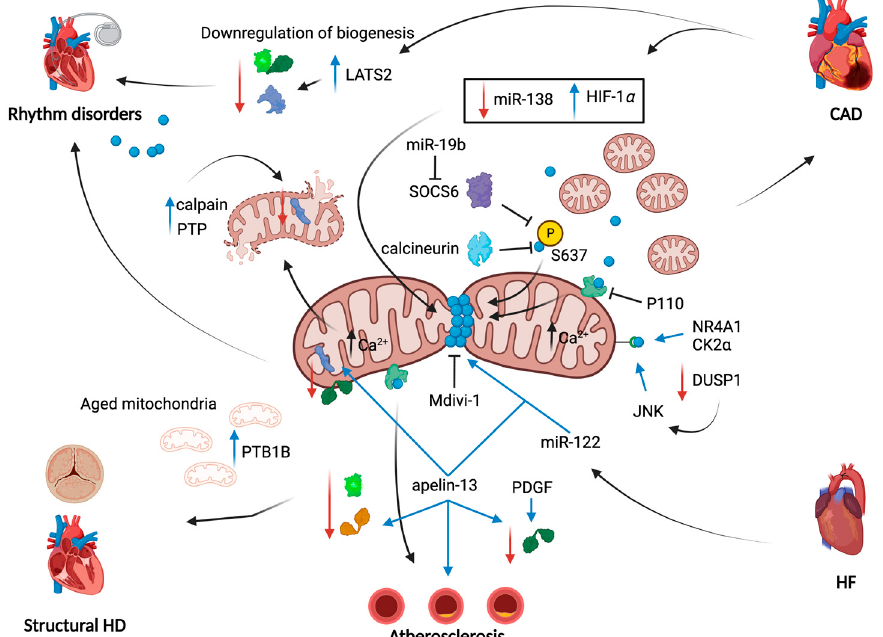
Figure 2. Mitochondrial dynamics alterations in heart diseases. Schematic overview of molecular pathways through which mitochondrial fission, fusion and biogenesis contribute to pathological aspects of heart diseases. Overall, mitochondrial fragmentation is the main common feature of heart diseases reported in this review. The ways by which mitochondria become fragmented are multiple and are aimed to anchor DRP1 to mitochondria. In CAD, a link with the HIF-1 α has been found and involves the downregulation of miR-138; a second miRNA, miR-19b, blocks SOCS6 kinase function to prevent DRP1 phosphorylation on Ser-637. The same effect is obtained by the increase in activity of calcineurin. A concomitant decrease in mitochondrial fusion has been reported: in atherosclerosis development, apelin-13 promotes the downregulation of MFNs and OPA1. Also, mitochondrial biogenesis is downregulated through the loss of PGC-1 α , NRF1/2 and TFAM expression, especially in CAD and in rhythm disorders in a Hippo pathway-dependent manner. Red arrows: downregulation of a given protein/pathway; blue arrows: upregulation of a given protein/pathway; black arrows: cause-effect link.